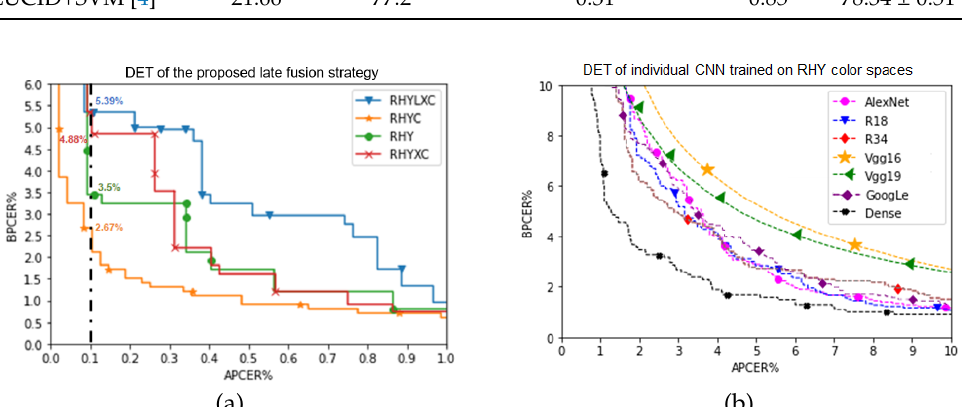
Figure 7. ( a ) DET Curves illustrate the performance of late fusion on the overall system. ( b ) DET Curves illustrate the RHY finger photo patches trained on individual